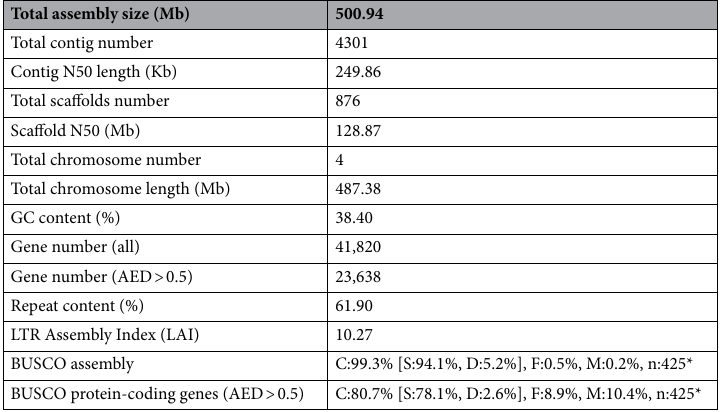
Table 1. Summary of P. ovata genome assembly and annotation. AED, Annotation Edit Distance; LTR, Long Terminal Repeat; C, Complete; S, Complete and single-copy; D, Complete and duplicated; F, Fragmented; M, Missing BUSCOs;*, Viridiplantae_odb10, BUSCO